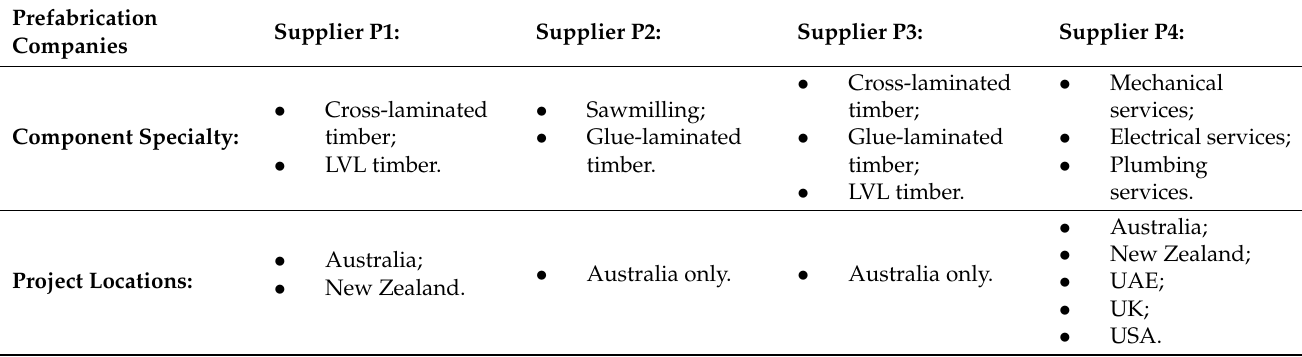
Table 2. Prefabrication Companies in Content Analysis of